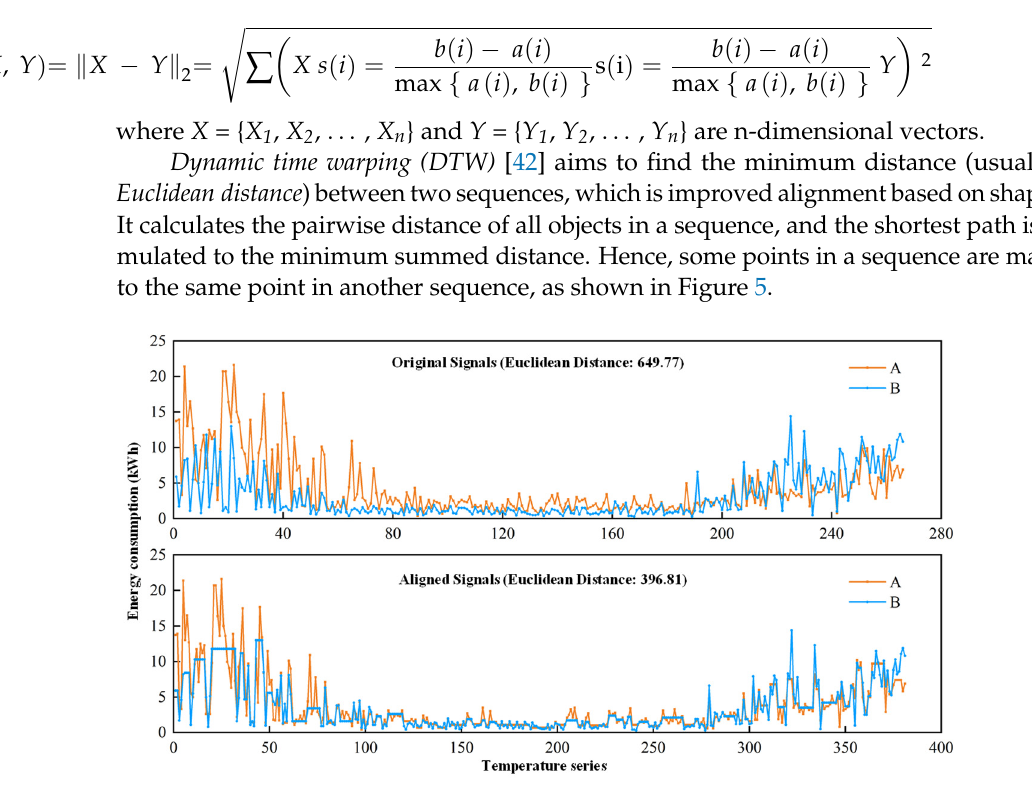
Figure 5. Pairwise match in using of DTW.